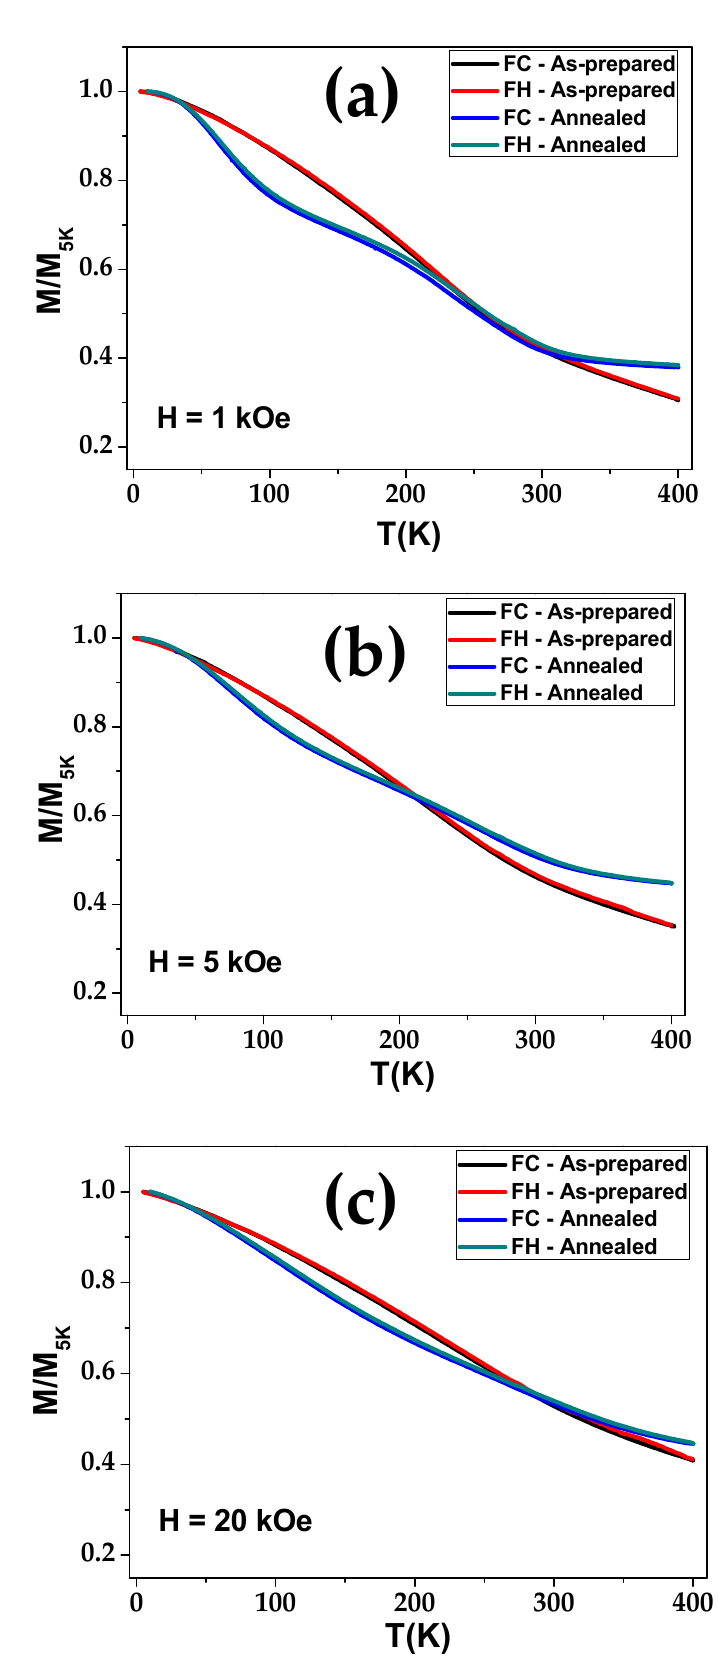
Figure 5. Temperature dependence of magnetization measured for annealed Ni 2 FeSi glass-coated microwires with applied external magnetic field ( a ) H = 1 kOe, ( b ) H = 5 kOe, and ( c ) H = 20